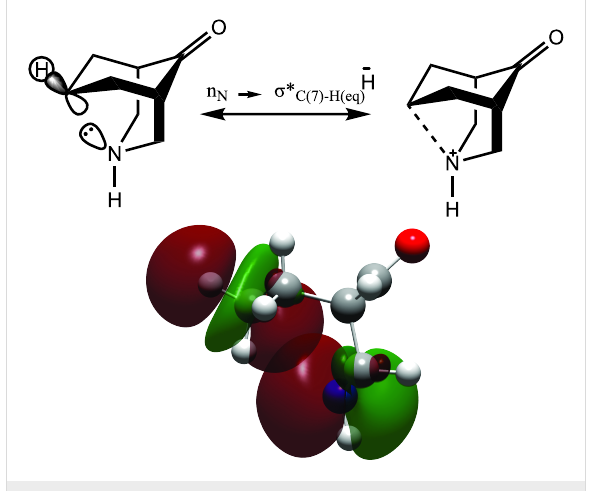
Scheme 3: Representation of the n N →σ * C–H(7)eq interaction. The interaction energy is 0.55 kcal/mol at the ω B97XD/6-311++G(d,p)